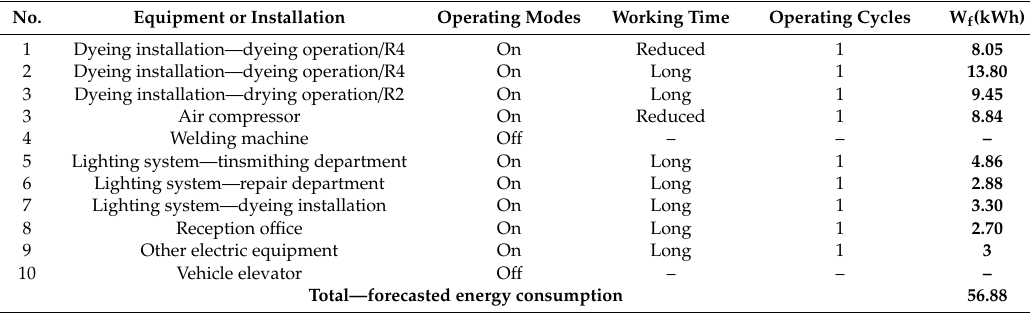
Table A3. The Decision Matrix and forecasted energy consumption for Monday.